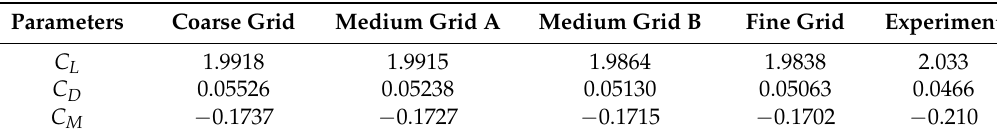
Table 4. Comparison of aerodynamic coefficients at AoA = 13.40 ◦ .